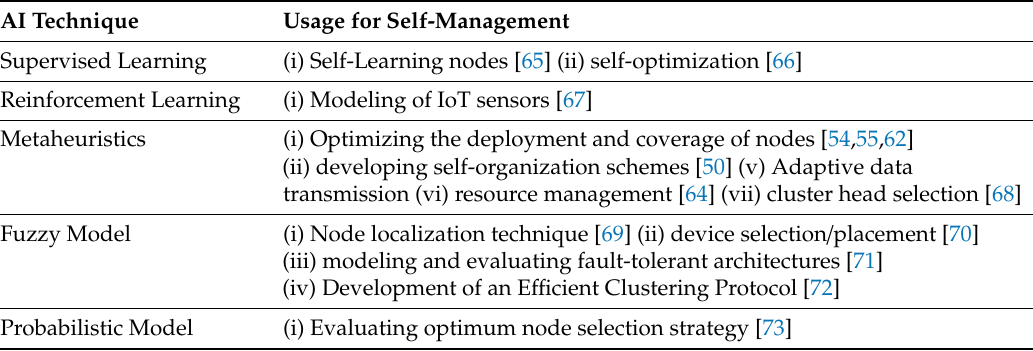
Figure 8. Potential self-optimization tasks with potential for AI integration. Table 3. Summary of the usage of AI in IoT self-management .